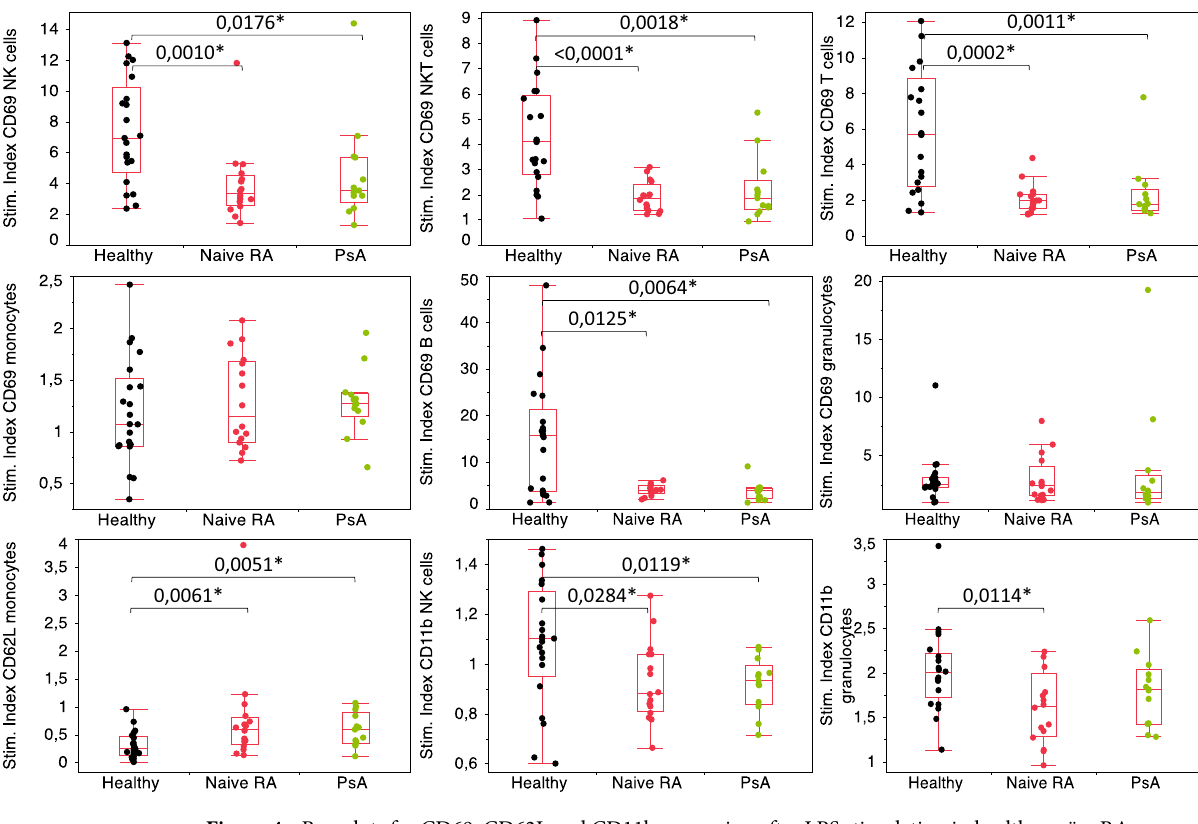
Figure 4. Box plots for CD69, CD62L and CD11b expression after LPS stimulation in healthy, naïve RA and PsA patients. Stimulation indexes (Stim. Index) were obtained by normalizing MFI values from the LPS condition by the negative condition. Statistical significance was determined by a nonparametric Wilcoxon test, with * p values < 0.05.